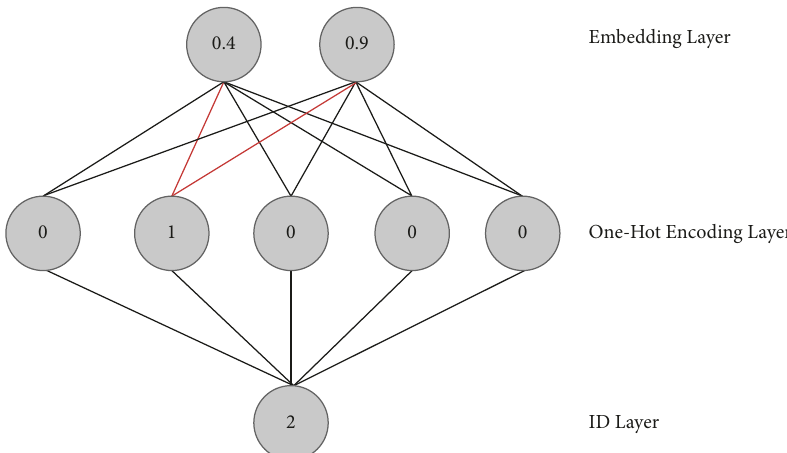
Figure 5: The procedure of embedding vectors.